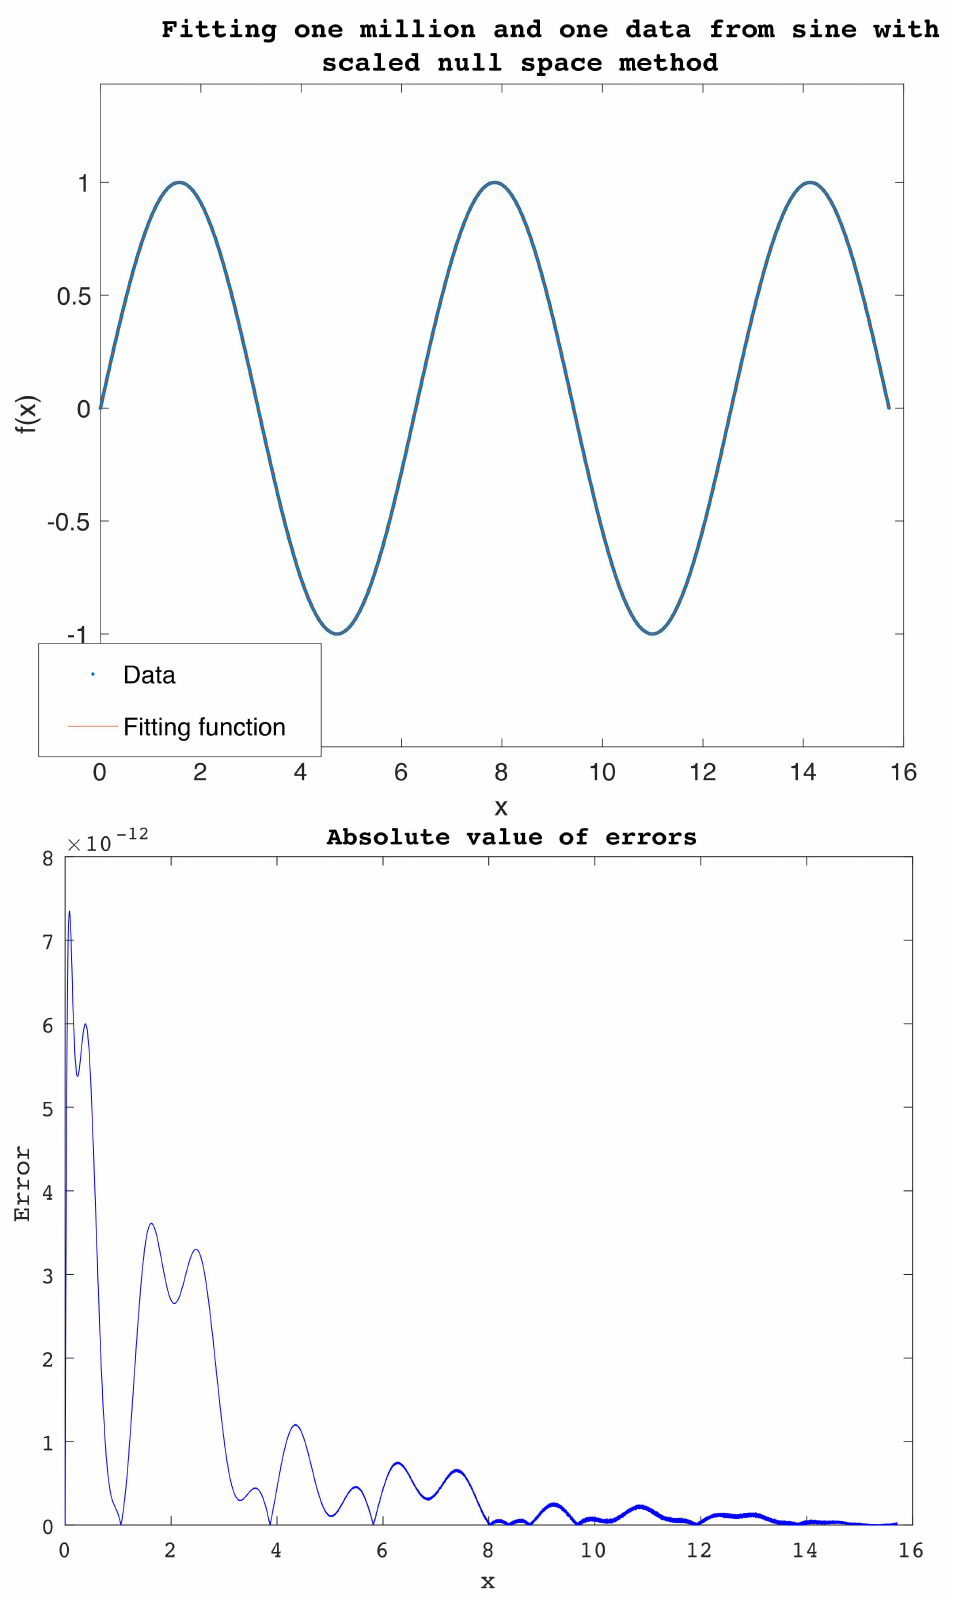
Figure 14. Fitting a very large data set (10 6 + 1) sampled from sine function with accuracy that is comparable with samples in hundreds in size, as lower error plot shows. It might be difficult to see fitting function in red on top plot at first look due to extreme small errors and high number of data represented by blue